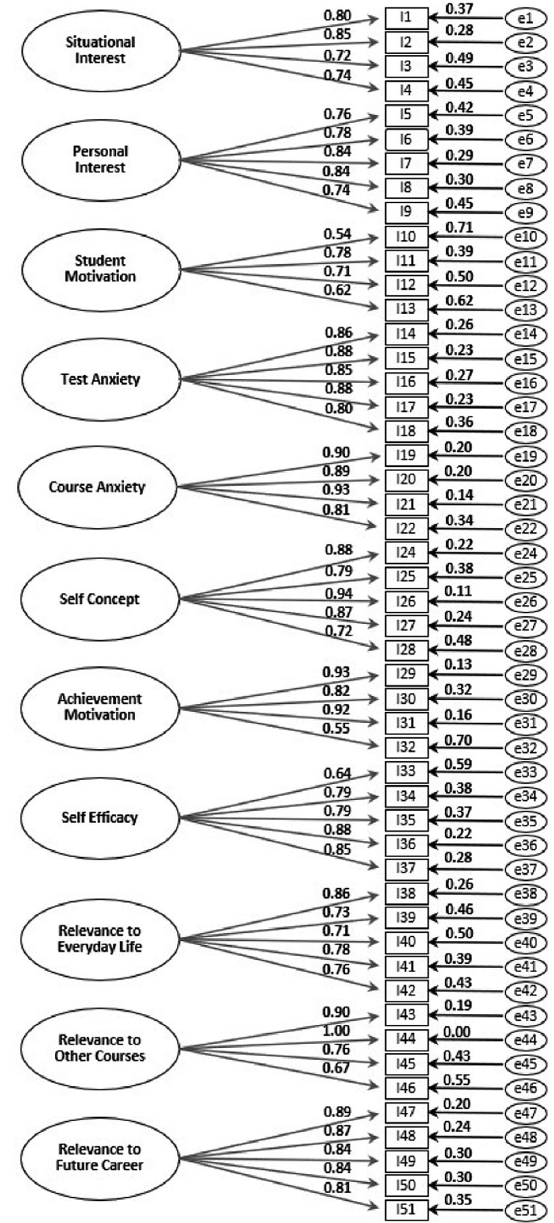
FIG. 1. Path diagrams for the CFA of the model with item 23 deleted. The numbers on the arrows represent the standardized loadings. All loadings were significant. Standardized errors are presented on the arrows at the right side of each